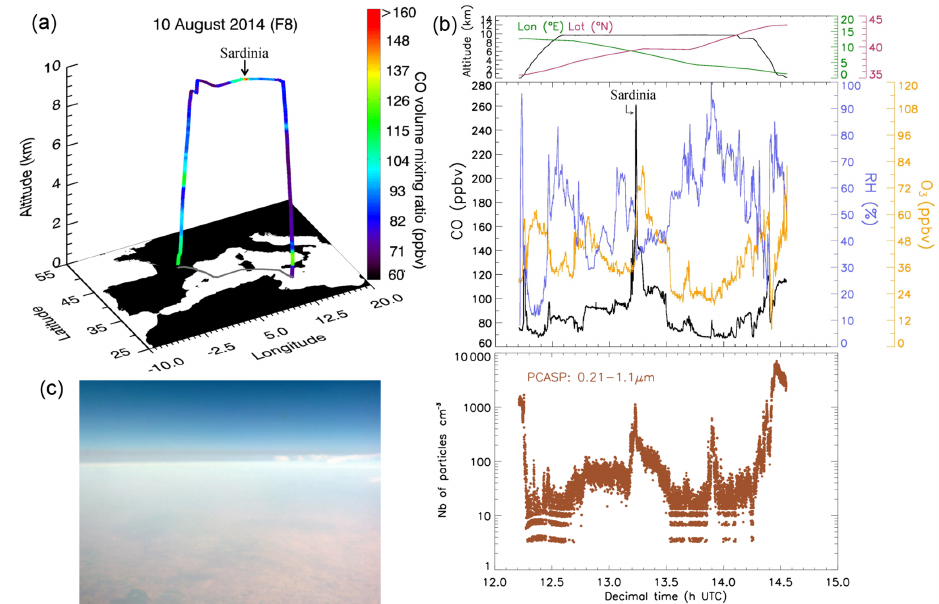
Figure 1. Flight F8 (10 August 2014). (a) Three-dimensional trajectory colour-coded according to CO volume mixing ratios (vmr) between Lampedusa and Toulouse. (b) Top – flight altitude, longitude and latitude as a function of time; middle – time series of CO (black) and O 3 (orange) vmr and relative humidity (blue); bottom – aerosol total number concentrations (brown). (c) Picture of a dark thin layer from the Falcon 20 at an altitude of 9.7km at